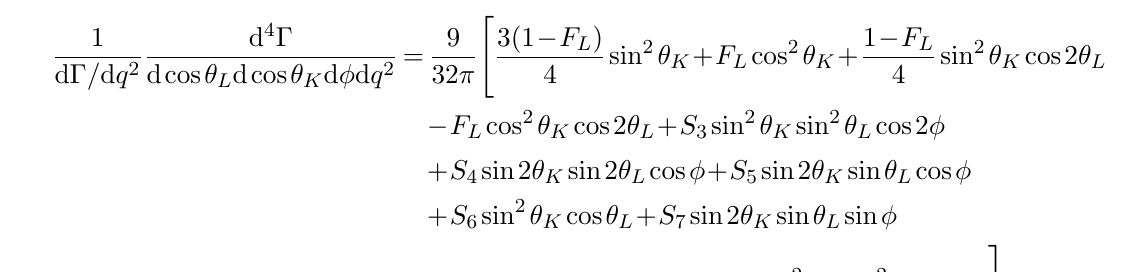
, (cid:18) and (cid:30) de(cid:12)ned K L meson, d